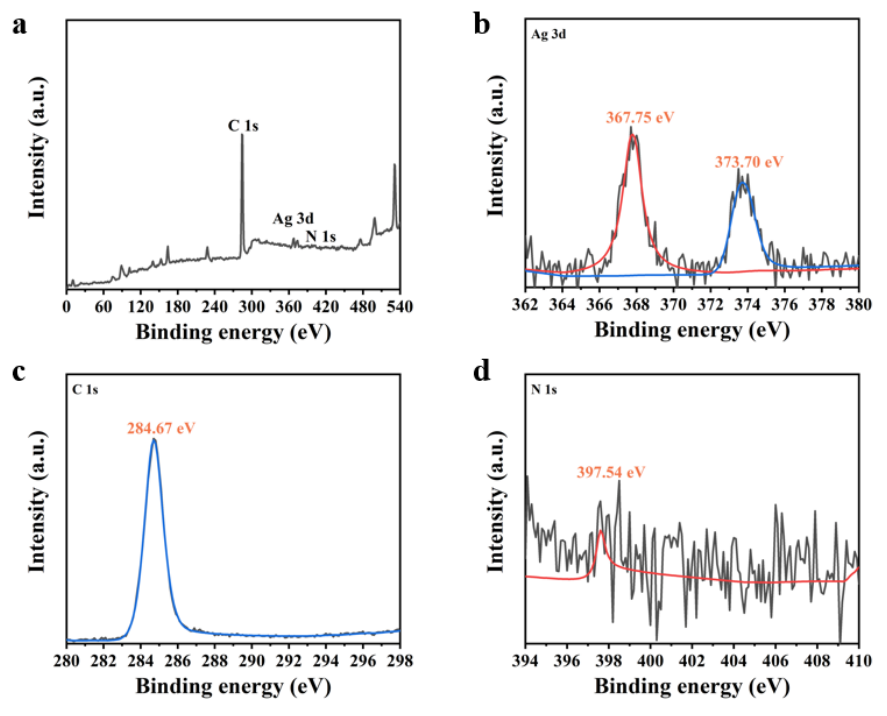
Figure 7. ( a ) XPS full spectrum and element spectrum of P3HT@Ag 2 NCN composite films; high- resolution of Ag3d ( b ), C1s ( c ), and N1s ( d ), respectively.